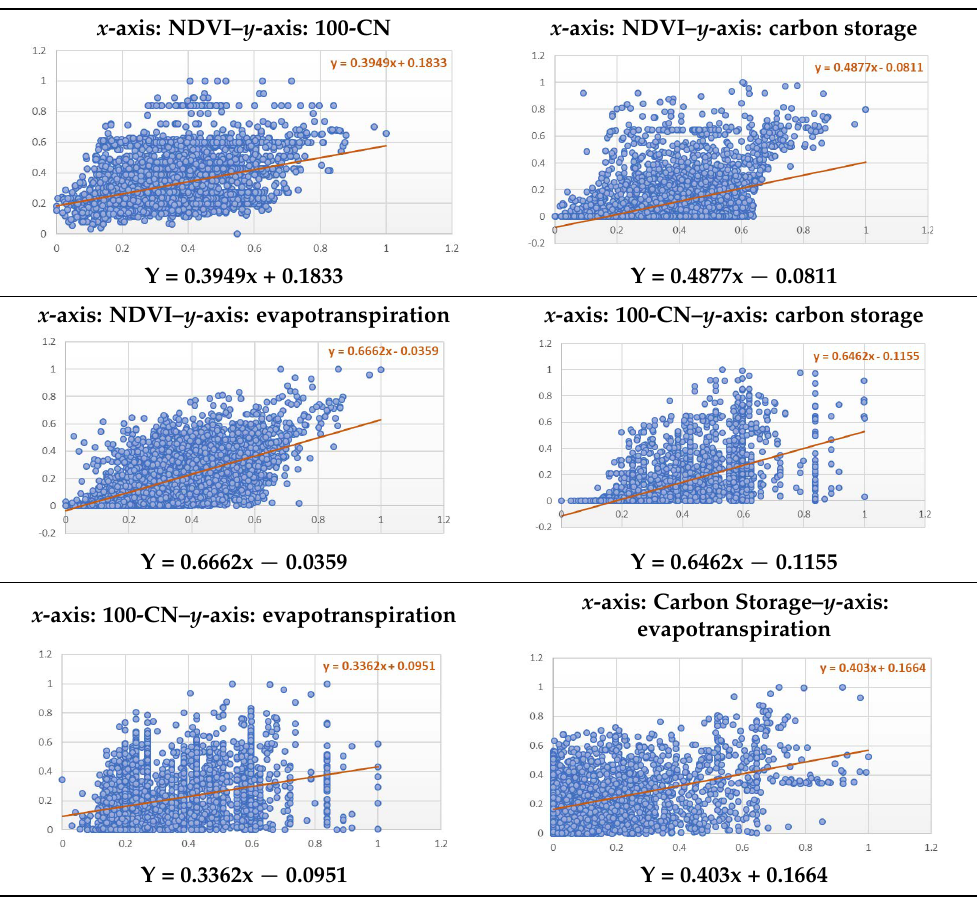
Table A6. Linear regression slopes: type E.